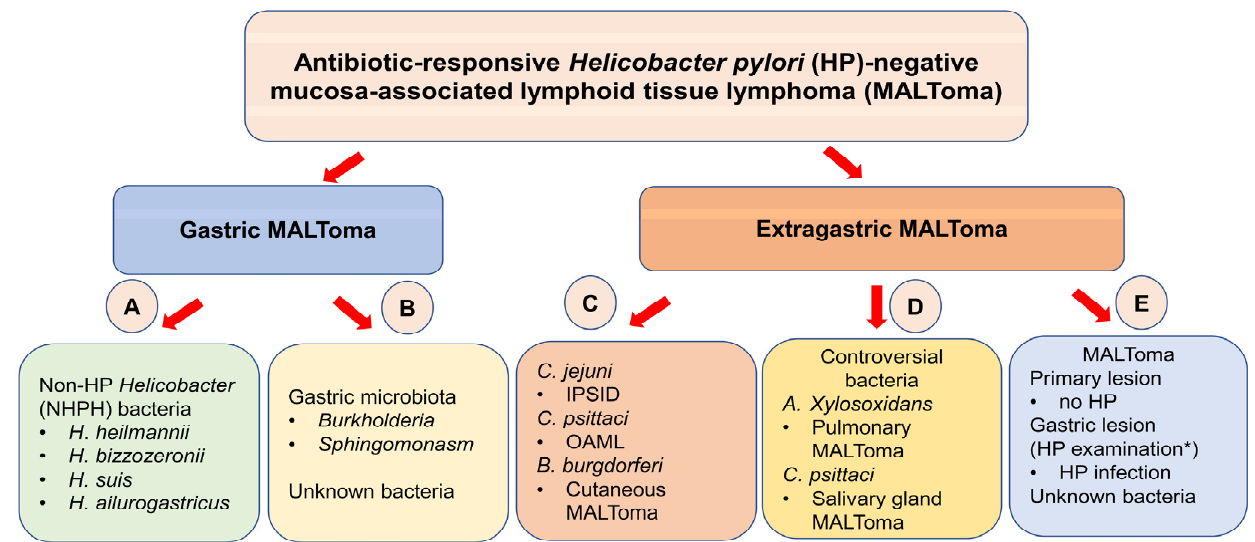
Figure 1. Schema of the spectrum of antibiotic-responsive Helicobacter pylori (HP)-negative mucosa- associated lymphoid tissue (MALT) lymphoma. ( A ) Among antibiotic-responsive HP-negative gastric MALT lymphoma, non-HP Helicobacter (NHPH) bacteria, such as H . heilmannii, H. bizzozeronii, H. suis , and H. ailurogastricus can be detected in sporadic cases. However, the precise mechanisms of NHPH on antibiotic-responsiveness remain unclear. ( B ) Gut microbiota, such as genera Burkholderia , Sphingomonasm , and unknown microbiota, may be involved in the lymphomagenesis of antibiotic- responsive HP-negative gastric MALT lymphoma. ( C ) C. jejuni , C. psittaci , and B. burgdorferi are reported to be associated with the development of immune proliferative small intestinal diseases (IPSID), ocular adnexal MALT lymphoma (OAML), and cutaneous MALT lymphoma, and the use of doxycycline, tetracycline, metronidazole, doxycycline, or cephalosporin to eradicate the aforementioned bacteria, respectively, was found to be efficacious. ( D ) However, the association between A. xylosoxidans and the occurrence of pulmonary MALT lymphoma is controversial, as is the association between C. psittaci and the development of salivary gland MALT lymphoma. ( E ) Among sporadic cases that respond well to first-line HP eradication therapy (HPE), the presence of HP in the stomach but no direct evidence of HP in the primary lesion may explain the possibility that antigen stimuli or indirect T-specific lymphocytes or cytokines/chemokines homing to within the primary site from the lymphatic system of the stomach can be attenuated by the eradication of HP through HPE. * HP examination: histologic examination, rapid urease test, 13 C urea breath test, and serology